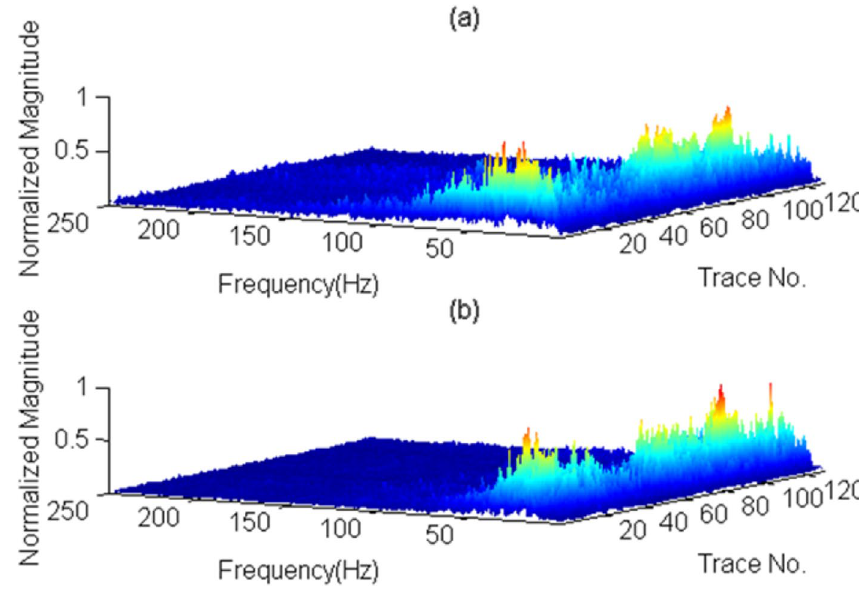
Fig. 13 Comparison of the fre- quency spectra. a The raw data.